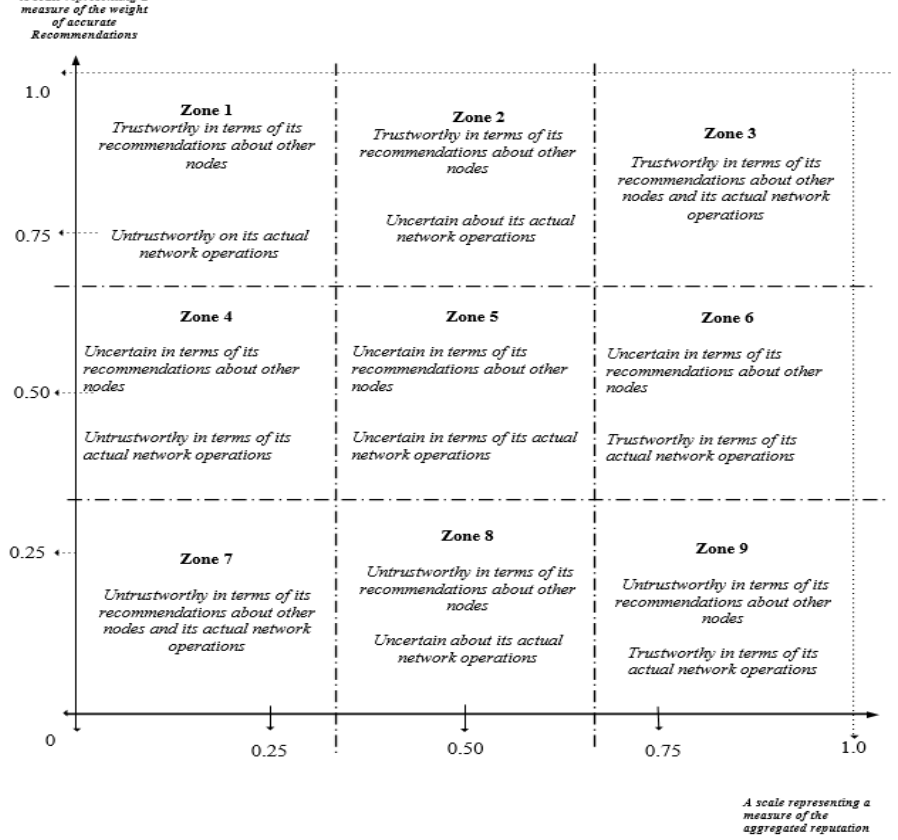
Figure 1. Two-dimensional view of trustworthiness evaluation of a node.